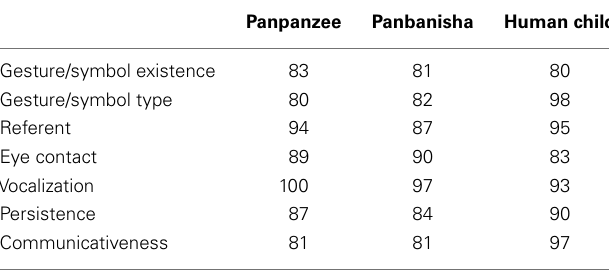
Table 1 | Reliability: percentage agreement between two independent